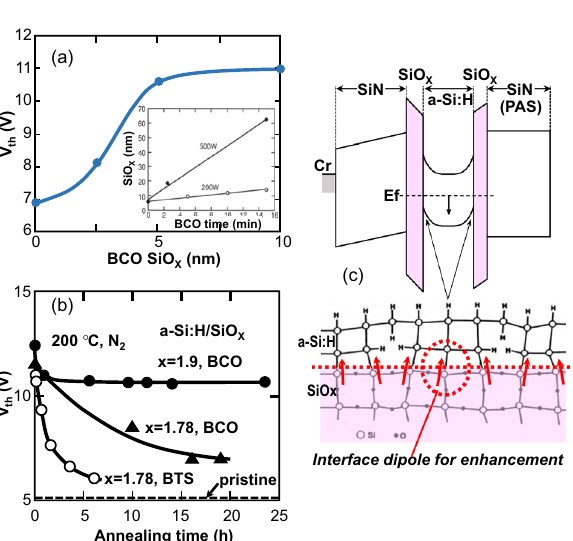
Figure 7. ( a ) Effect of back-channel oxidation (BCO) and passivation (PAS) on Id–Vg characteristics of MNOS TFT. ( b ) Vth and Vth standard deviation, σVth, after BTS and after BCO without BTS treatments and ( c ) SiO X thickness as a function of position along gate-line, x.